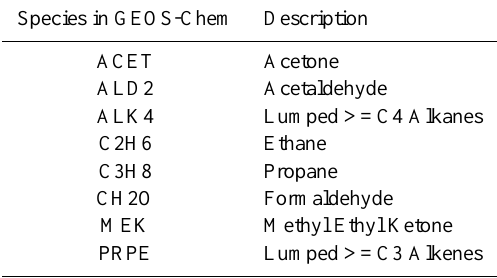
Table A3. Description of GEOS-CHEM NMVOC emitting species from anthropogenic sources ∗ .